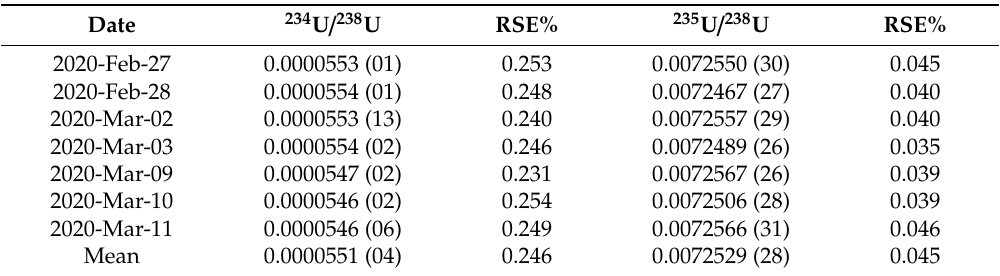
Table 4. Replicate analyses of Uranium isotope ratio measurement of the in-house standard